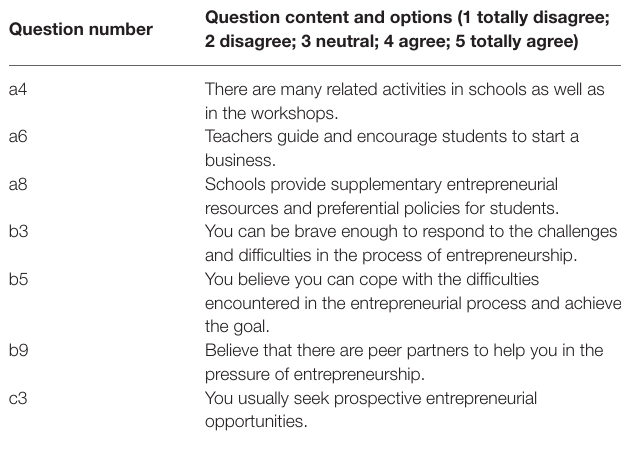
TABLE 1 | Some questions in the